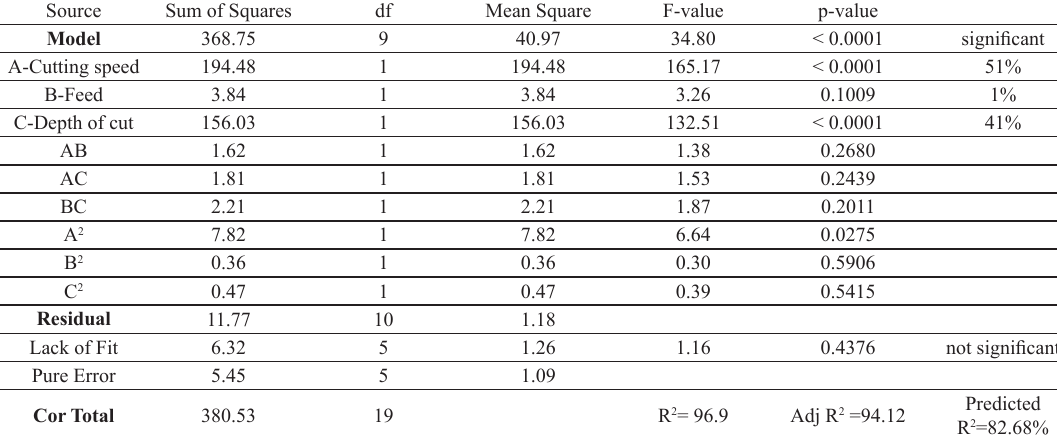
Table 5. ANOVA for prediction of tool tip temperature.